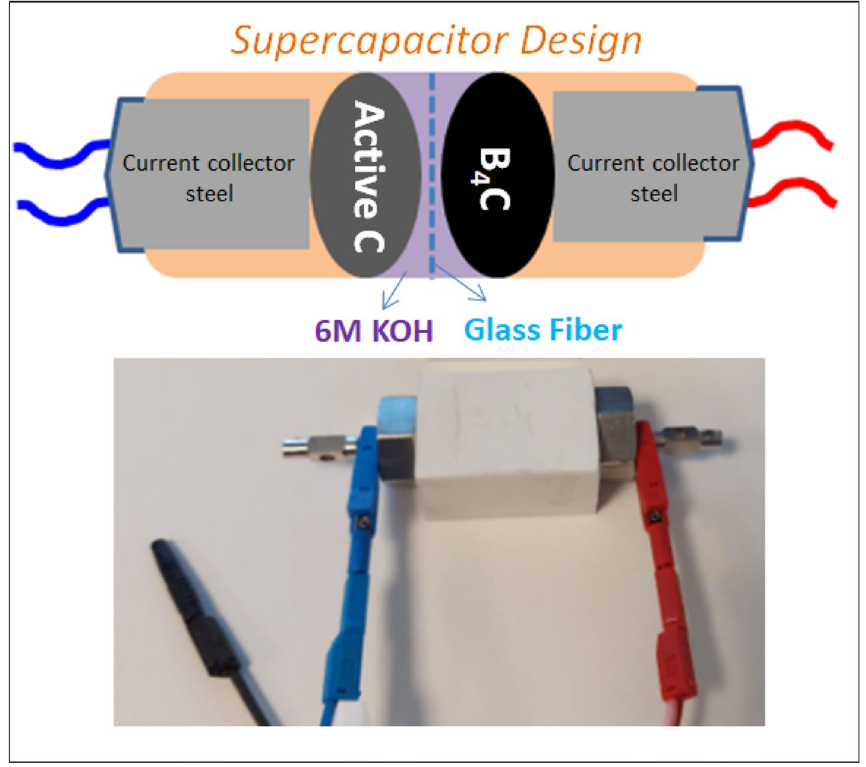
Figure 2. Design of the supercapacitor device and its real photograph while it is testing via